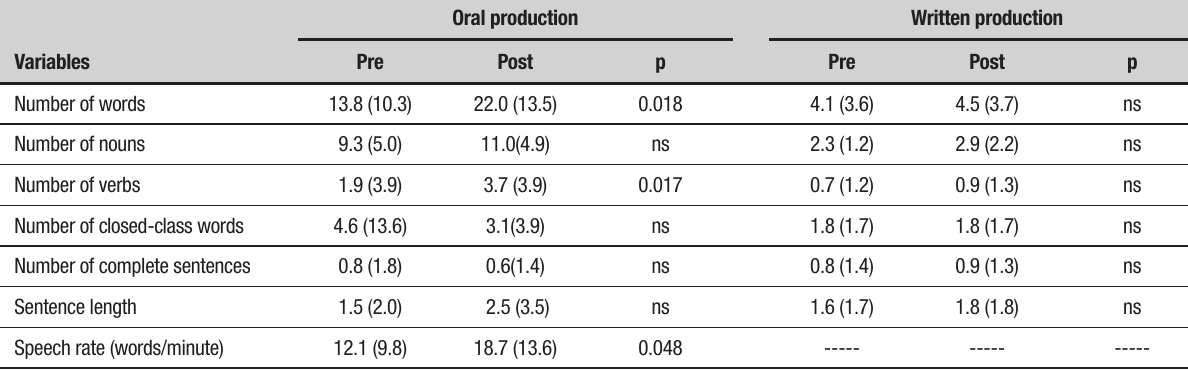
Table 3. Performance of subjects at pre and post-treatment using ORLA.